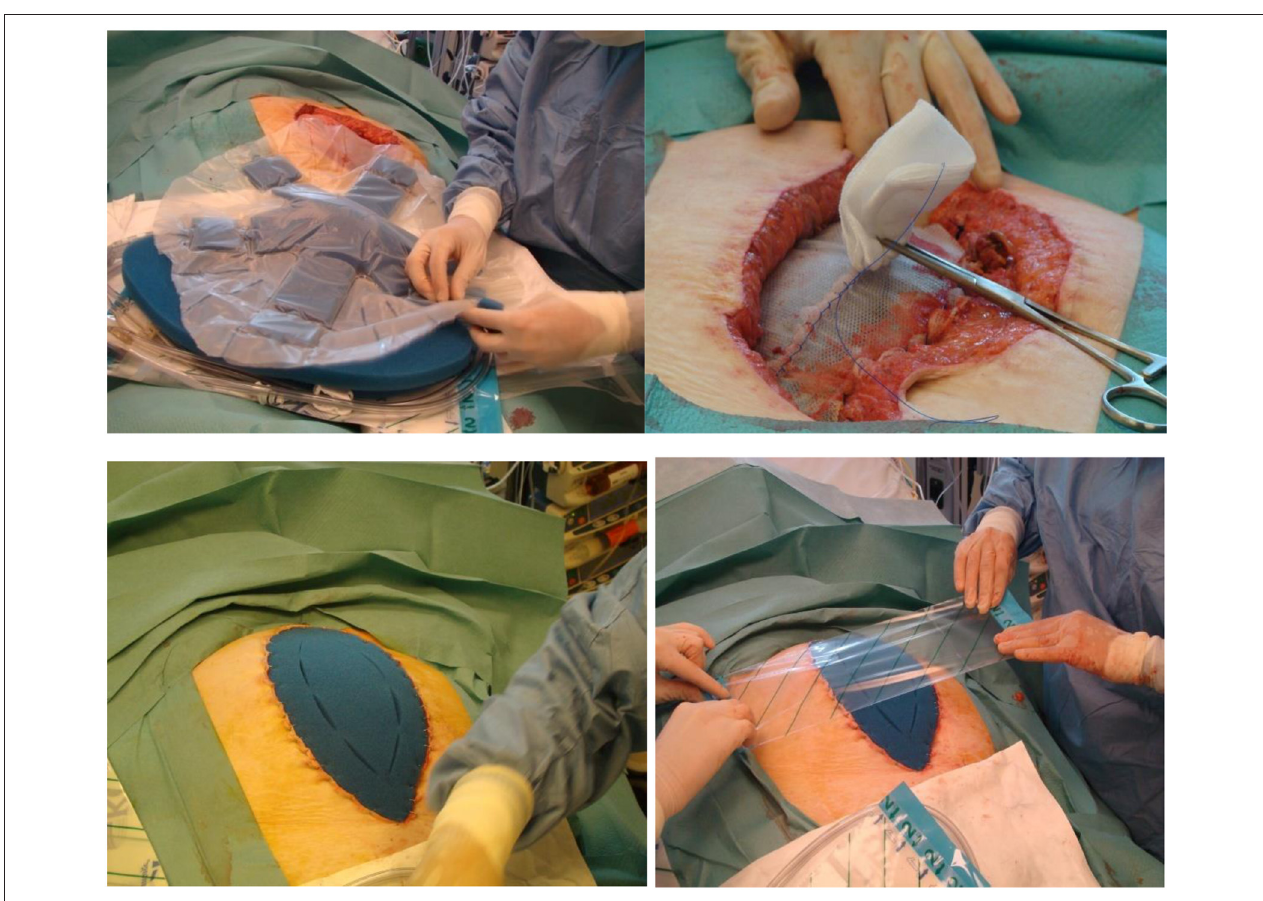
FIGURE 1 | Technique of vacuum assisted mesh mediated fascial